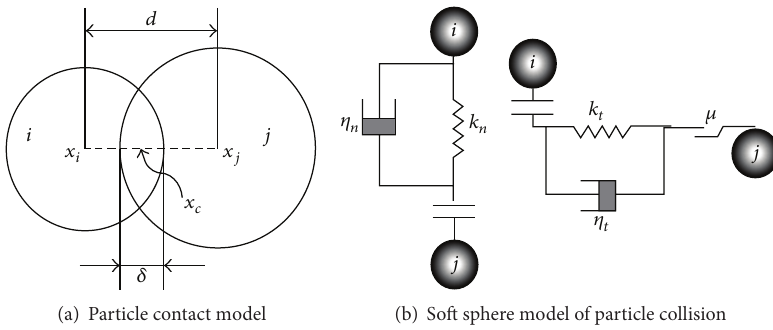
Figure 2: Models of contact force in soft sphere approach.